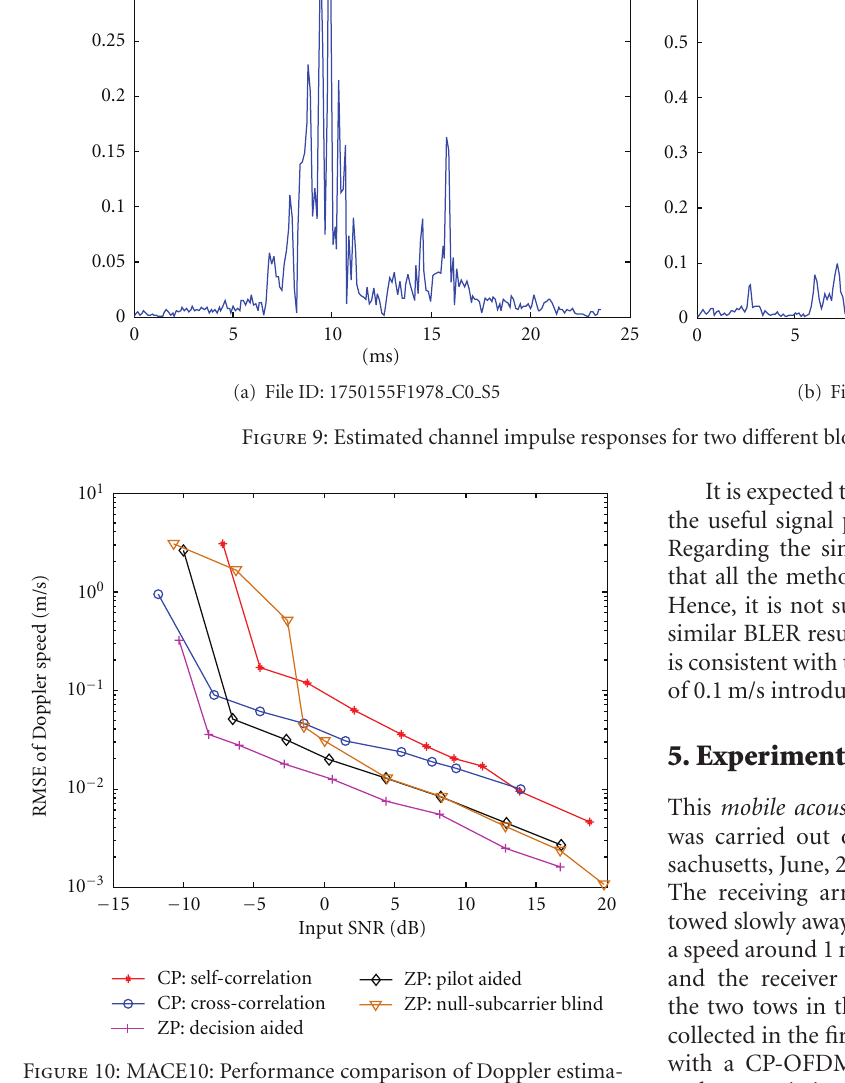
Figure 10: MACE10: Performance comparison of Doppler estima- tion approaches, file ID: 1750155F1954 C0